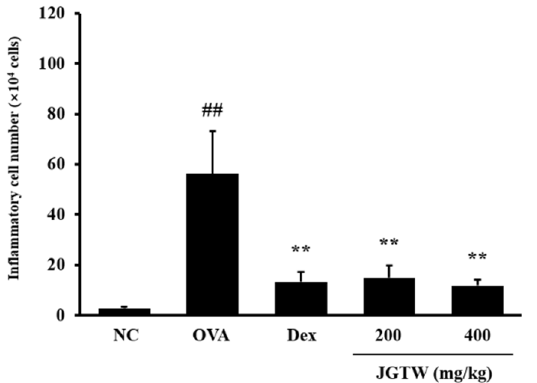
Figure 8. Effect of JGTW on number of inflammatory cells in OVA-induced mice. Number of BALF cell were counted using a light microscope with a hemocytometer. The values are presented as mean ± SEM. ## p < 0.01 versus NC group; and ** p < 0.01 versus OVA-induced group.